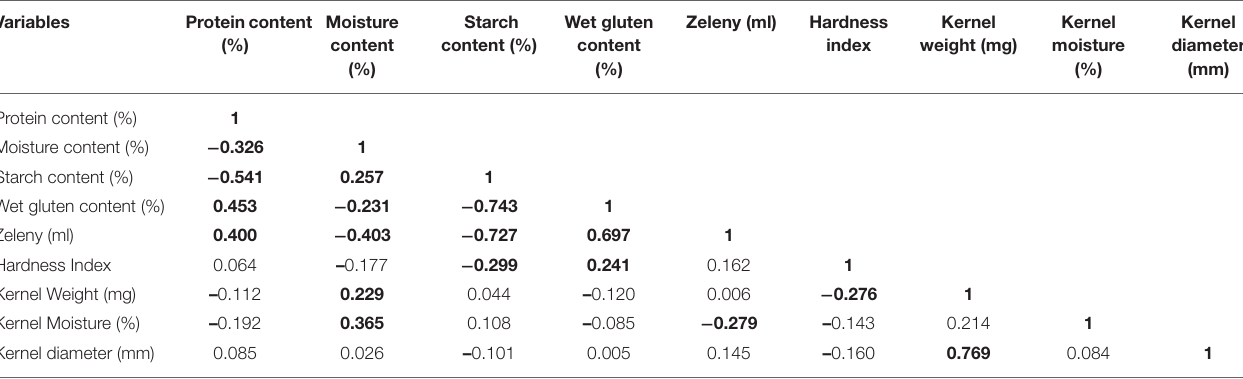
TABLE 2 | Correlation matrix among different quality parameters in wheat genotypes.